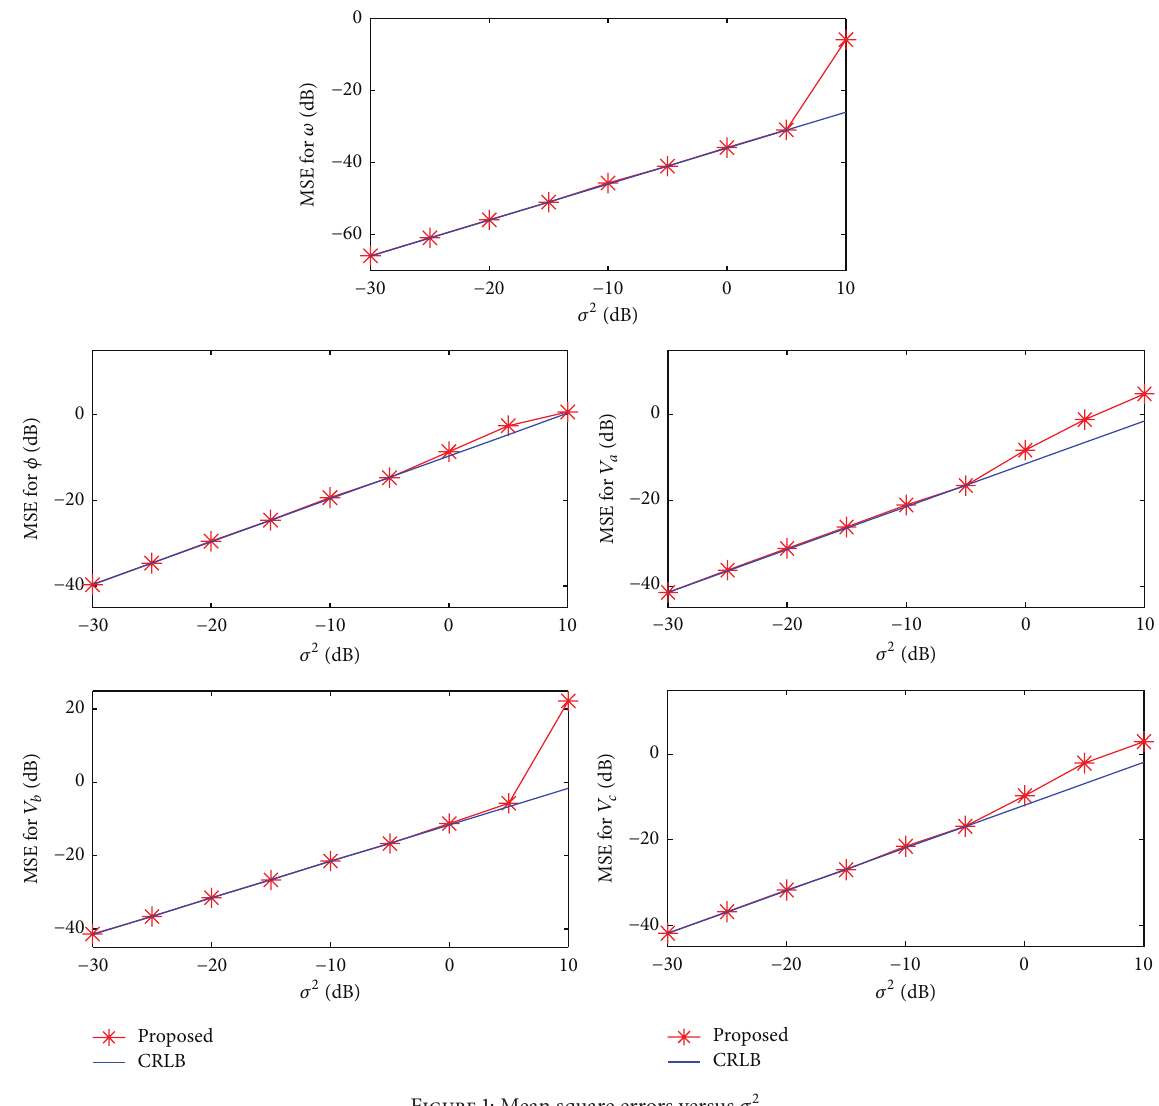
Figure 1: Mean square errors versus 𝜎 2